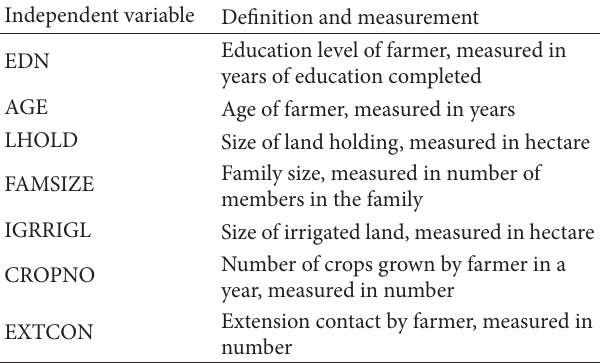
Table 1: Definition of variables in empirical model.